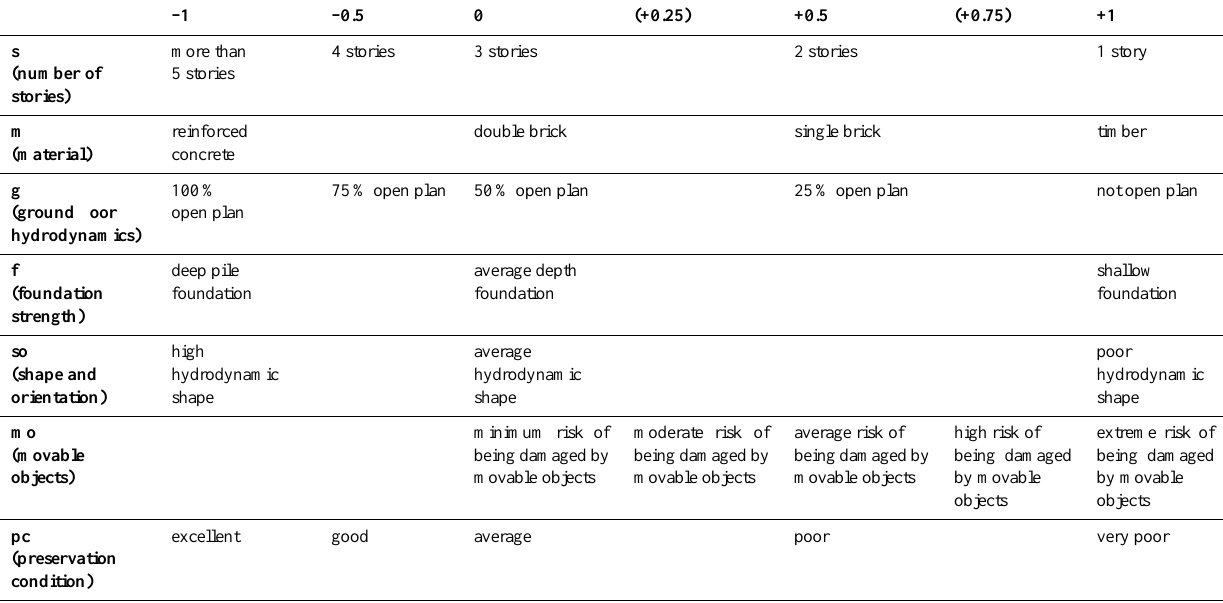
Table 2. The attributes (and their values) influencing the structural vulnerability of a building “Bv”. Positive values indicate an increase of the average building vulnerability given by the attribute, while negative values indicate a decrease of the average building